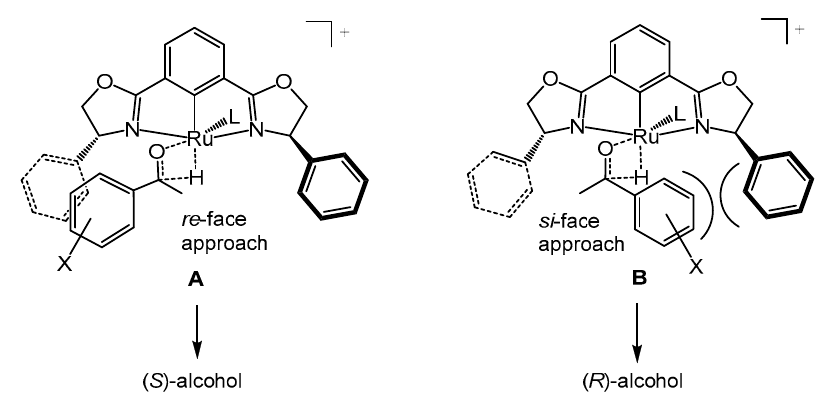
Figure 2. Proposed transition states for the asymmetric transfer hydrogenation of aryl ketones.